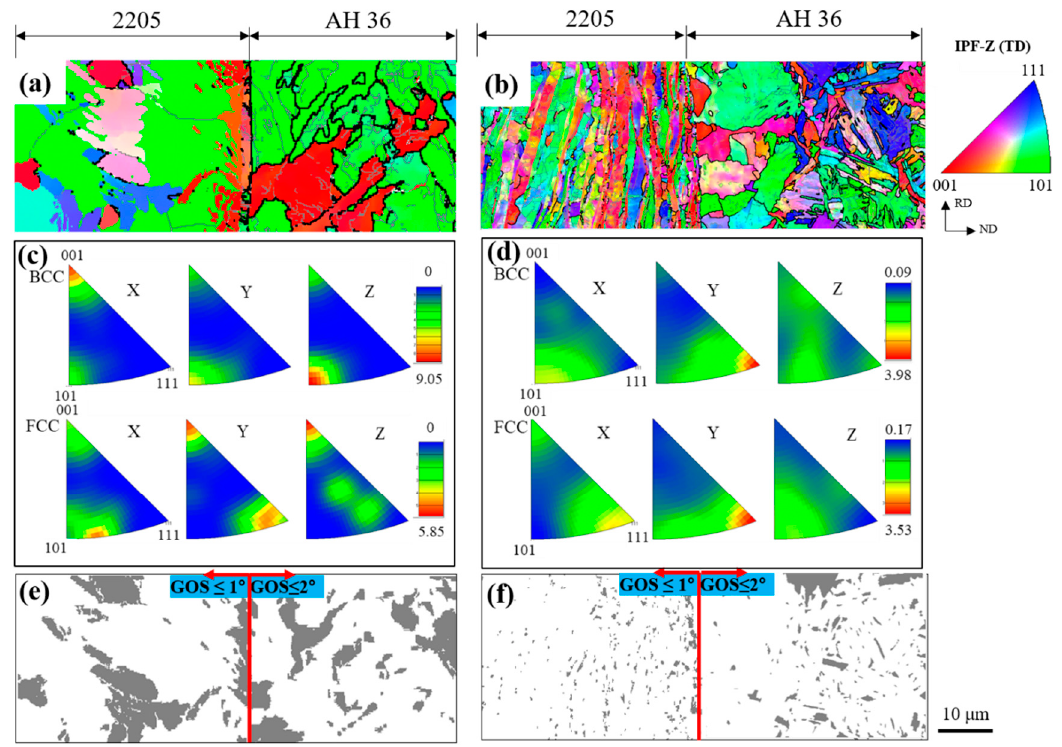
Figure 8. Orientation map inverse pole figure (IPF)-Z direction, IPF and grain orientation spread (GOS) maps of tip zones at 950 °C–0.01 s –1 : ( a , c and e ), and at 950 °C–1 s –1 : ( b , d and f ). LAGBs = gray, HAGBs = black.